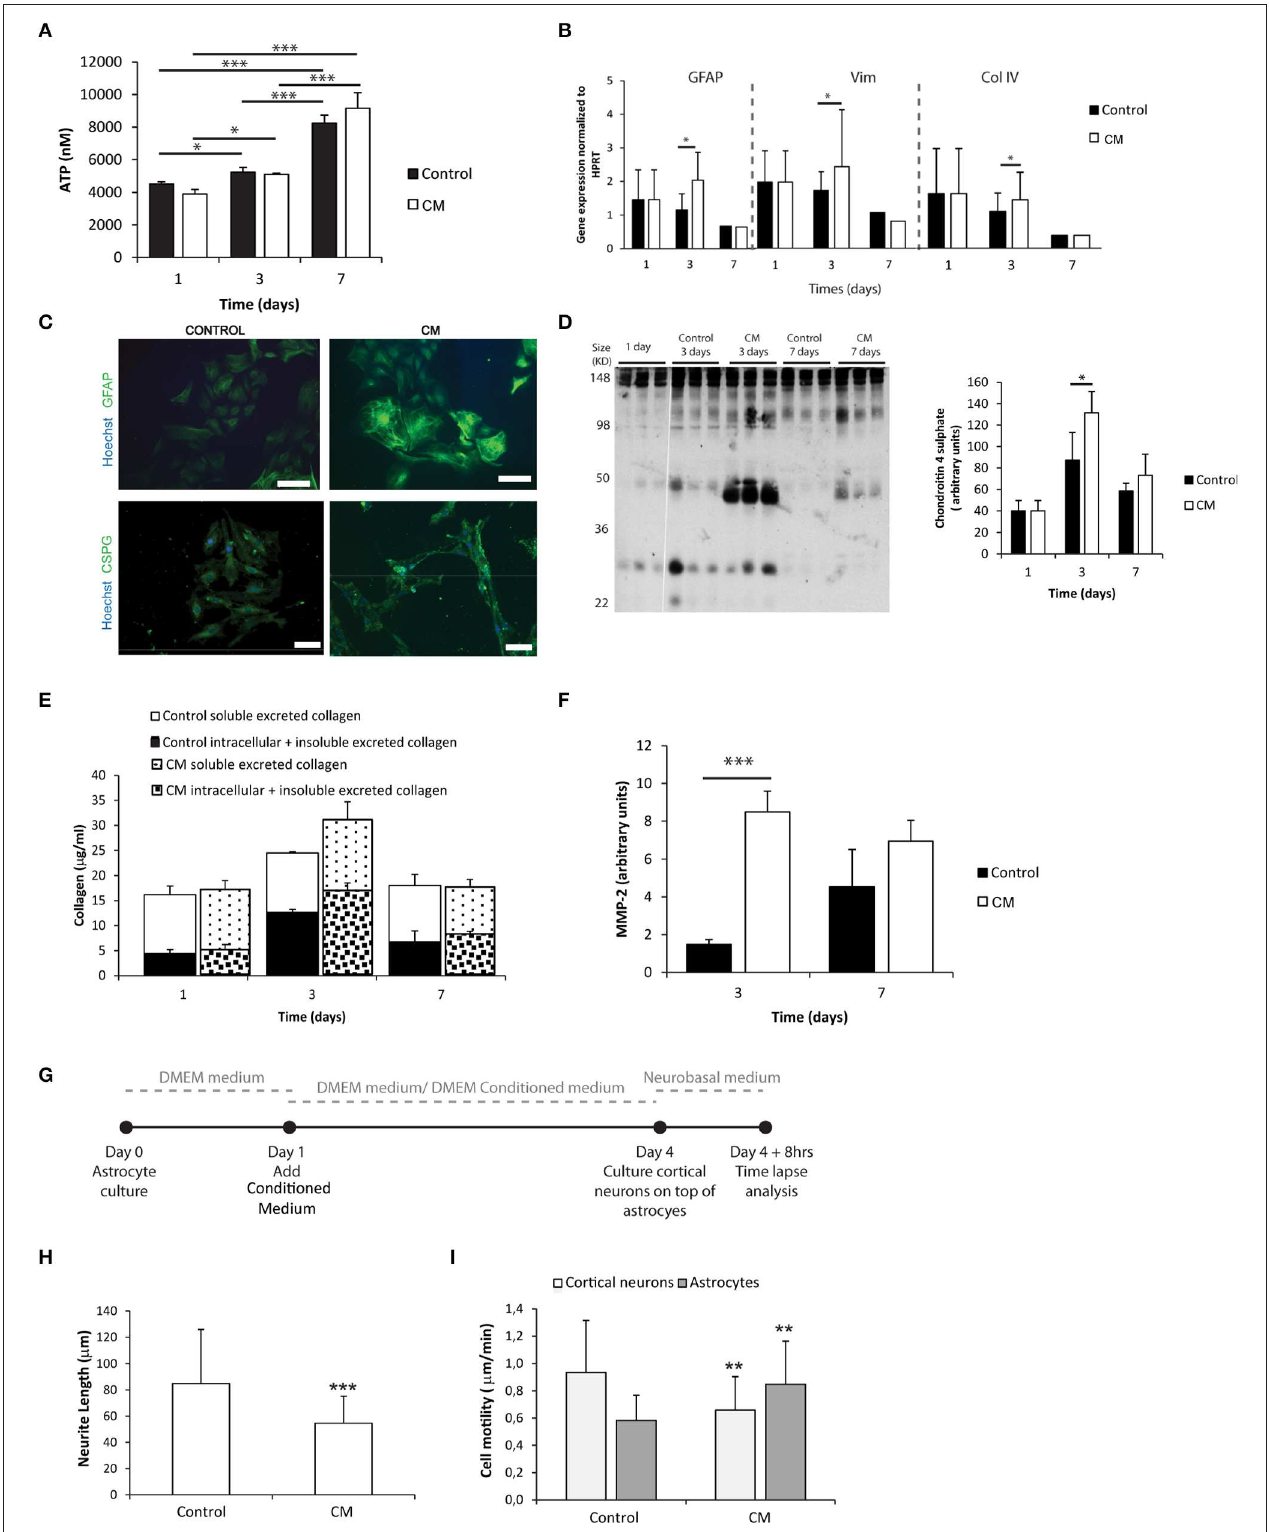
FIGURE 1 | Astrocyte 2D culture in the presence or absence of meningeal fibroblasts conditioned medium (CM). Results are shown as mean ± standard deviation; asterisks represent statistical differences, * p < 0.05 , ** p < 0.01 , *** p < 0.001 (A) ATP levels at 1, 3, and 7 days of culture ( n = 6 , statistical analysis